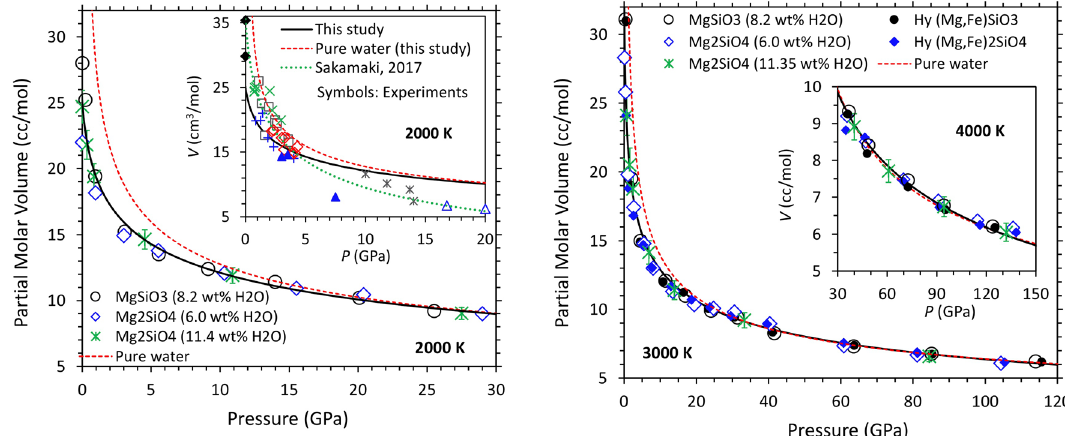
Figure 3. Calculated partial molar volume of water in hydrous MgSiO 3 enstatite melt (circles) and Mg 2 SiO 4 forsterite melts (diamonds and asterisks) as a function of pressure at 2000, 3000, and 4000 K and hydrous Mg 0.75 Fe 0.25 SiO 3 (small solid circles) and Mg 1.5 Fe 0.5 SiO 4 (small solid diamonds) at 3000 and 4000 K. Also shown is the equation of state fit (solid curve) to all melt results collectively at each temperature in comparison with the calculated equation of state for pure water (this study). The inset on left shows the experimental data on the partial molar volume of water in several silicate melts in the temperature range 1273–2473 K projected to 2000 K using the model of Sakamaki 10 . Different symbols represent different melt compositions, plus: andesite 39 , solid triangle: basalt 12 , square: granite 40 , open triangle: komotiite 41 , open diamond: peridotite 5 , cross: phonolite 42 , and asterisk: ultramafic 4,31 ; solid diamond: hydrous silicate melts at 0 GPa 20,21 . The error bars are shown only for the hydrous forsterite results (asterisks) for the sake of clarity.